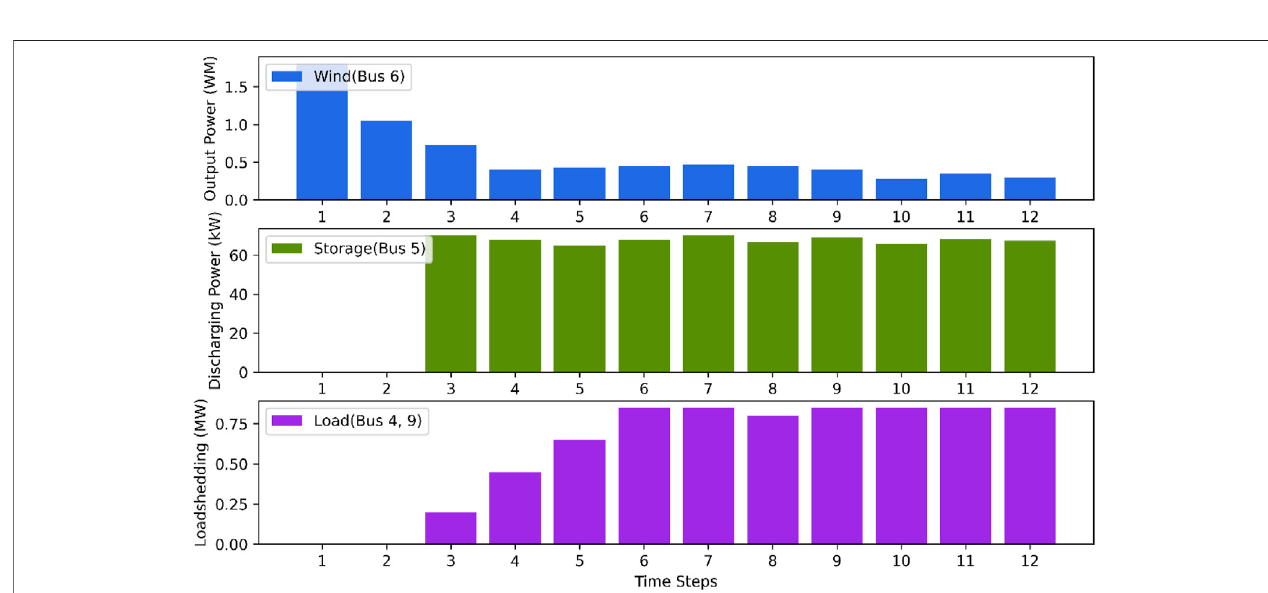
FIGURE 6 | Dispatch actions during low renewable power output.